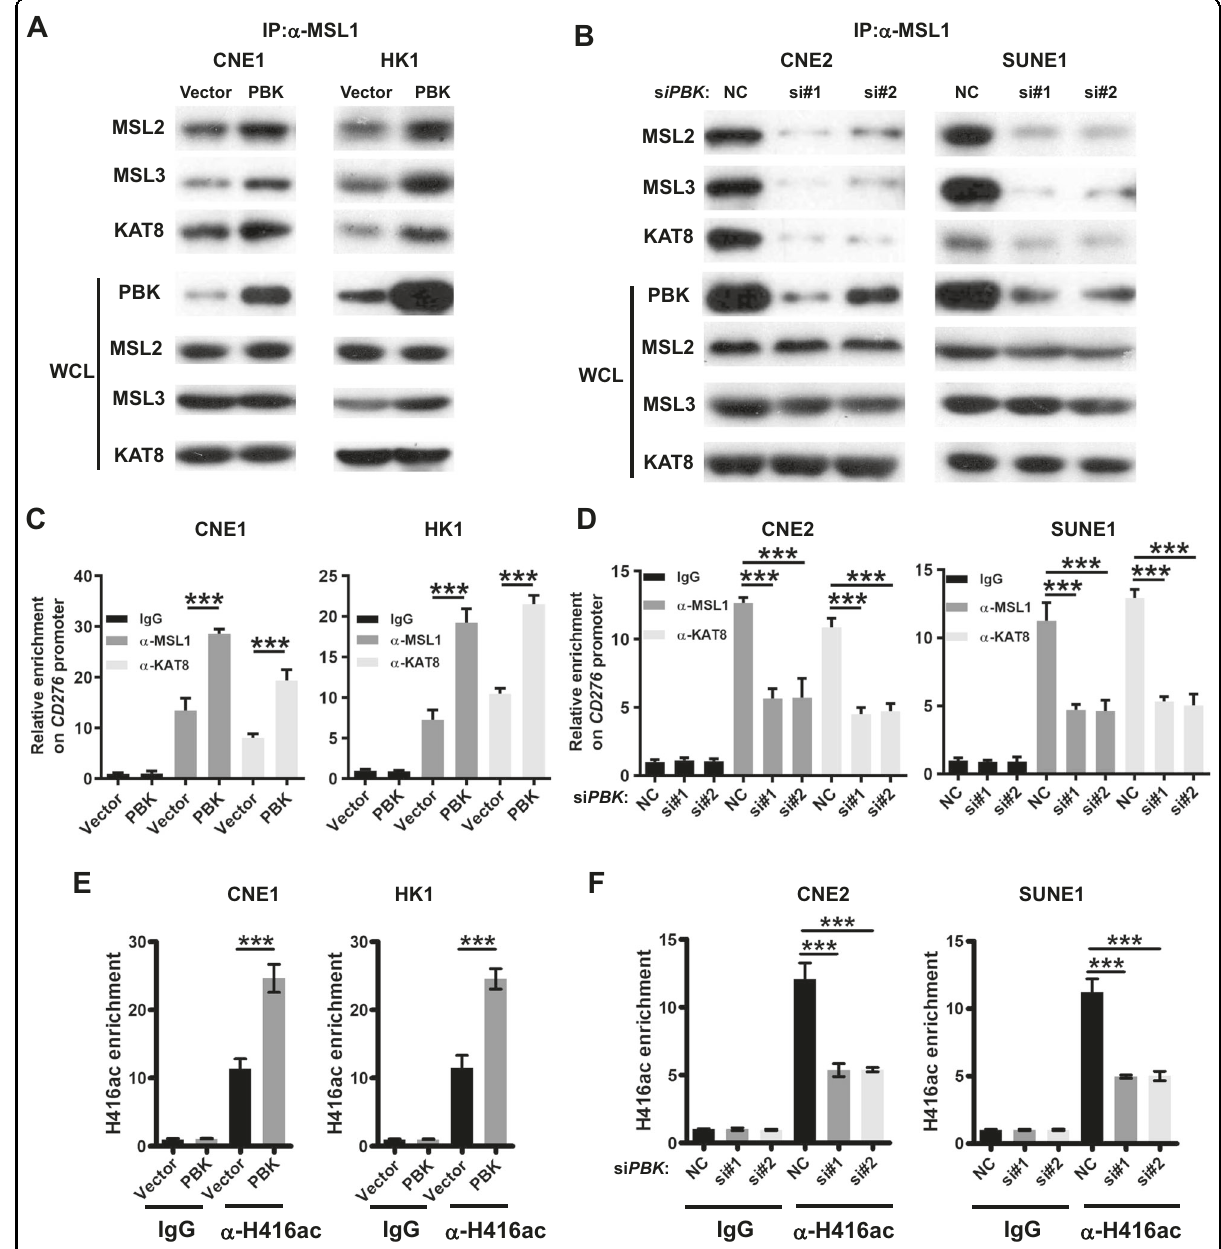
Fig. 4 PBK promotes the formation of MSL complex on the promoter of CD276 . A Immunoprecipitation assays with MSL1 antibody and immunoblotting analyses with the indicated antibodies were performed in PBK-overexpression stable cell lines. Left, CNE1, right, HK1. B CNE2 and SUNE1 cells were transfected with PBK siRNAs or NC (nonspeci fi c siRNA) for 48 h. Immunoprecipitation assays with MSL1 antibody and immunoblotting analyses with the indicated antibodies were performed. Left, CNE2, right, SUNE1. C ChIP-qPCR (chromatin immunoprecipitation- quantitative PCR) analysis of CD276 promoter using antibodies against MSL1 and KAT8 in PBK-overexpression or control cell lines. Left, CNE1, right, HK1. D ChIP-qPCR analysis of CD276 promoter using antibodies against MSL1 and MOF in PBK-knockdown or control cells. Left, CNE2, right, SUNE1. E , F ChIP-qPCR analysis of CD276 promoter using antibodies against H4K16ac (acetylation of histone H4 on lysine 16) in PBK-overexpression ( E ) or -knockdown cells ( F ). In C – F , ChIP-qPCR results were presented as the fold change over the vector/IgG or NC/IgG group. Error bars represent the mean ± SD (standard deviation) for three biological replicates. *** P < 0.001 (student ’ s t test for two groups, one-way ANOVA for three groups). All